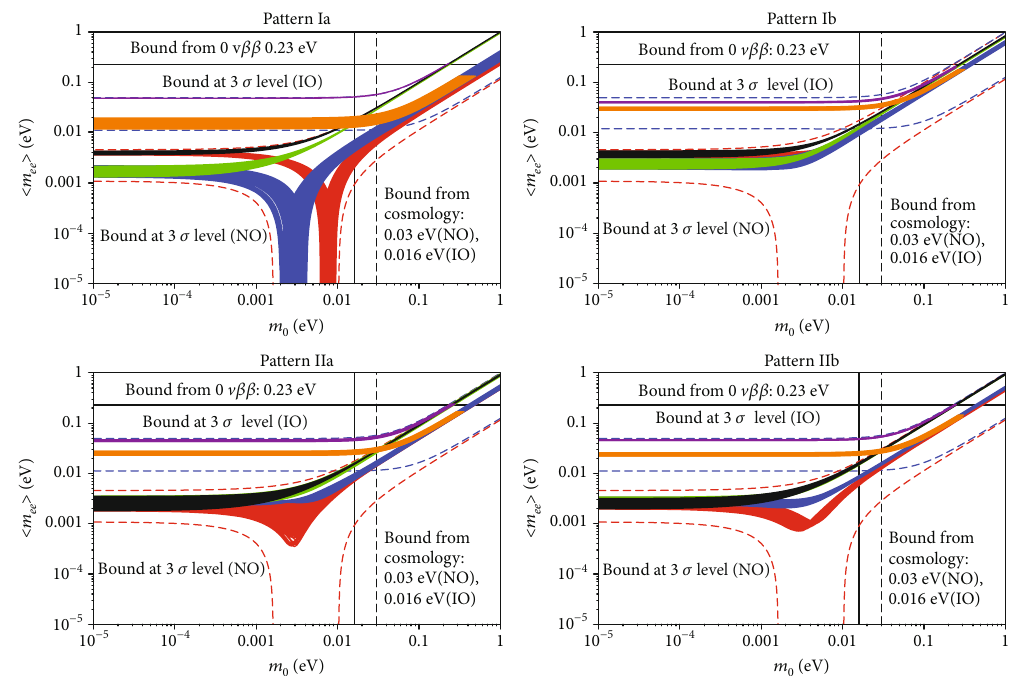
Figure 3: The e ff ective mass of neutrinoless double-beta decay h m The conventions follow those in Figure 2. The dashed boundary lines at the 3 σ level are obtained from the global fi t data